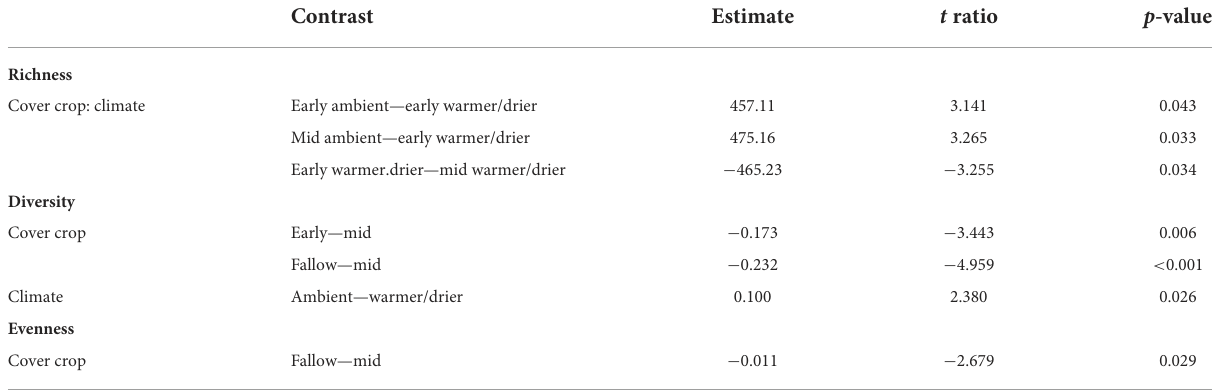
TABLE 2 Pairwise comparisons from Tukey’s post-hoc analysis of alpha diversity models for the 2018 samples.